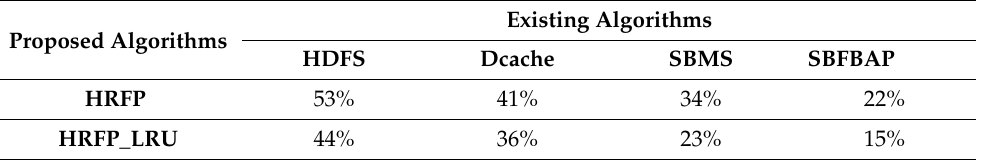
Table 2. Improvement of proposed algorithms performance in terms of ARAT compared with existing algorithms from